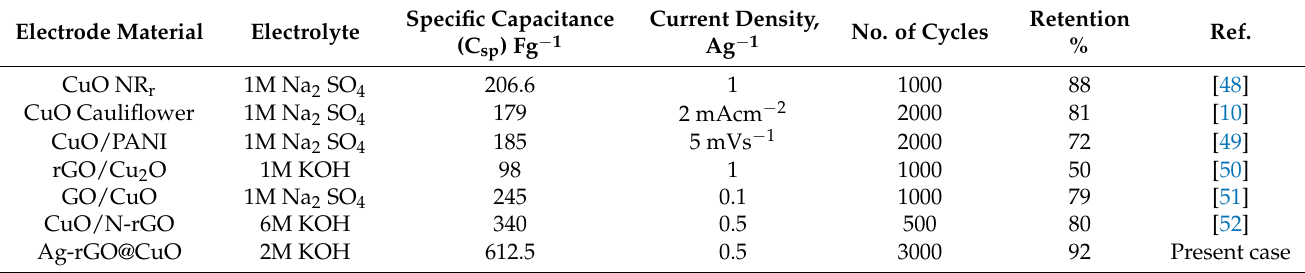
Table 2. Comparison between the capacitance of prepared ternary nanocomposite Ag-rGO@CuO against reported pure CuO and CuO based